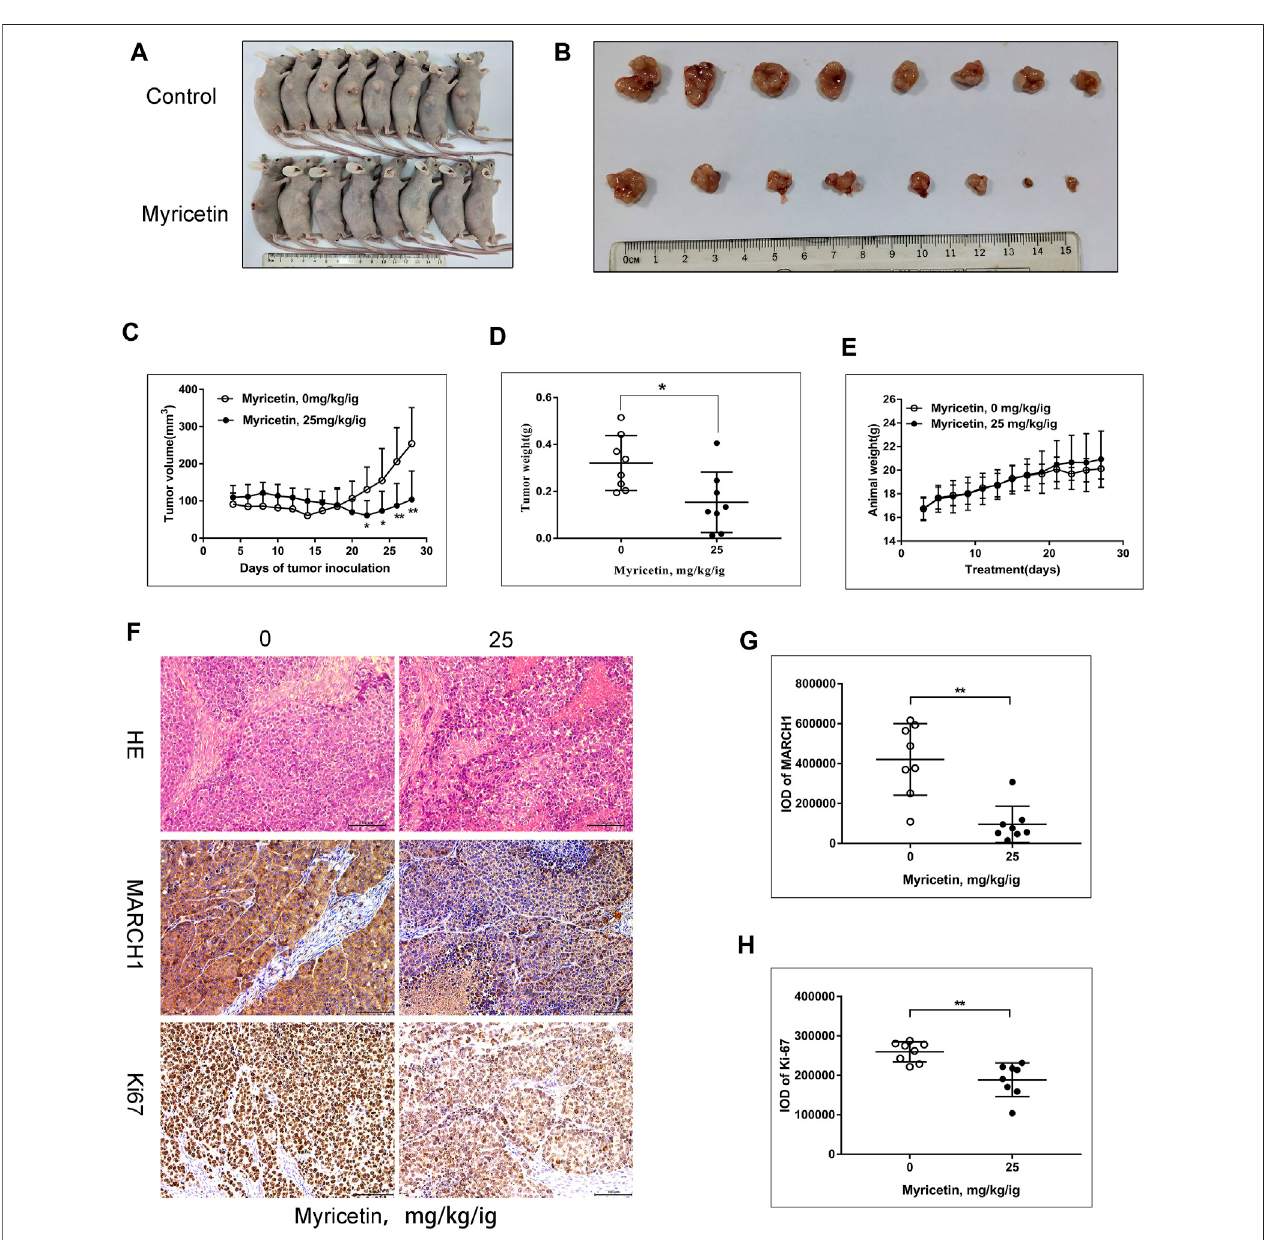
FIGURE 6 | Myricetin signi fi cantly reduces the growth of HCC xenograft tumor. (A) Image of BALB/C nude mice with or without myricetin treatment. (B) Image of tumor tissue in myricetin treated or untreated group. (C) The tumor volume during myricetin treatment was plotted. (D) Tumor weight in myricetin treated and untreated groups. (E) Mice body weight during myricetin treatment. (F) Tumor tissue sections identi fi ed by hematoxylin – eosin staining and immunohistochemistry. (G) IOD of MARCH1 in immunohistochemistry. Three fi elds were randomly selected from each sample. (H) IOD of Ki-67 in immunohistochemistry. Five fi elds were randomly selected from each sample. All data are presented as the means ± SD. * represents p < 0.05, ** represents p < 0.01.